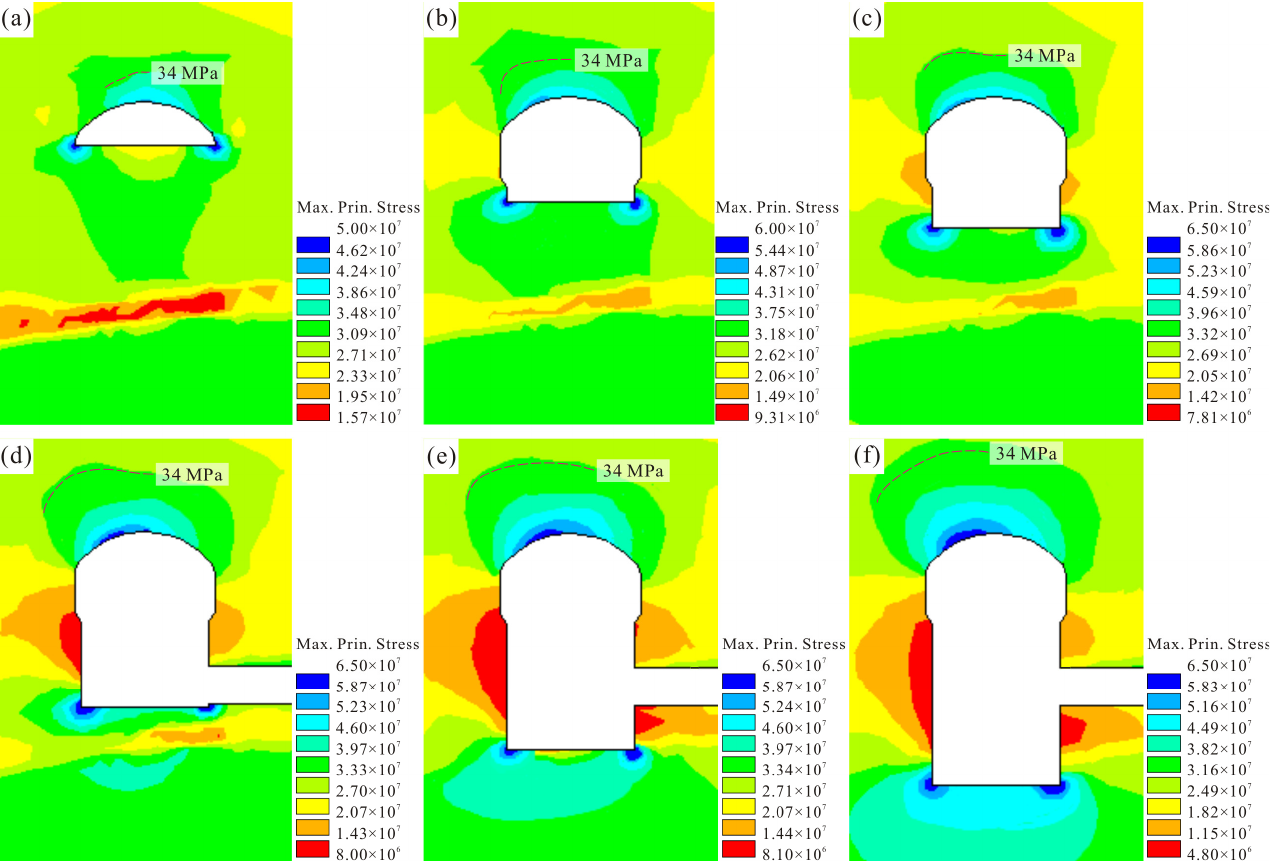
Figure 8. Numerical simulation results: the maximum principal stress distribution in surrounding rock mass during the excavation of ( a ) layer I, ( b ) III, ( c ) IV, ( d ) V, ( e ) VI and ( f ) VII (unit: Pa).